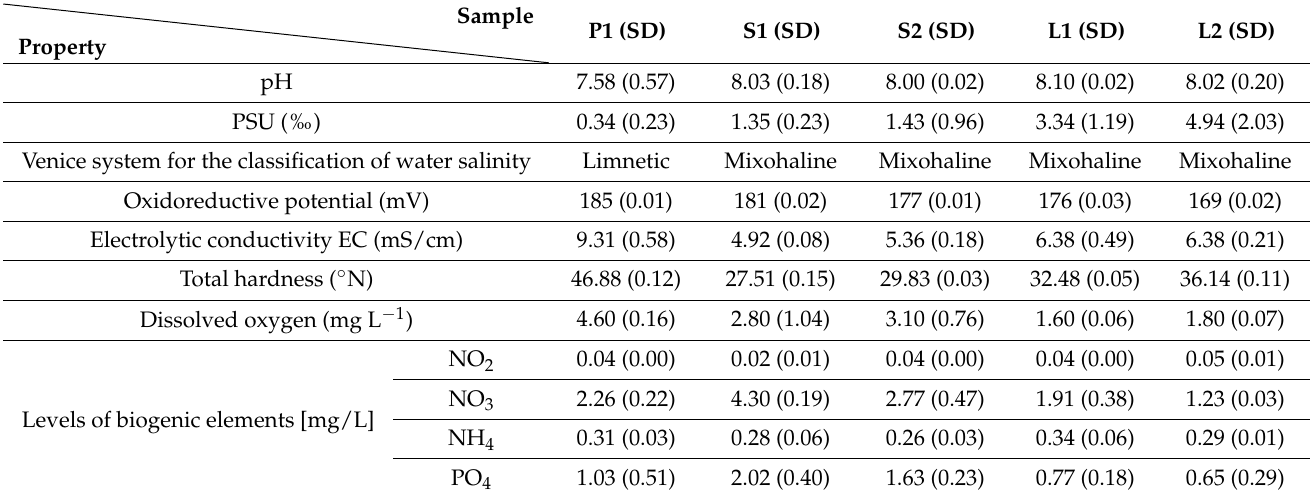
Table 1. Physical and chemical properties of autumn control and ship ballast water